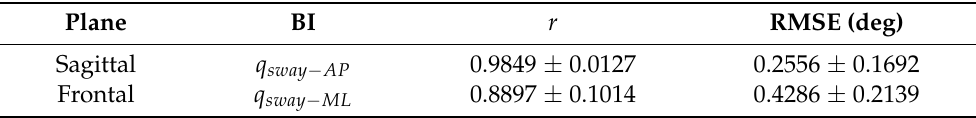
Table A2. Mean ± SD of the linear Pearson’s correlation coefficient ( r ) and RMSE for sagittal and frontal planes calculated between the sway angles ( q sway ) computed with the BenchBalance model and with Xsens MVN system. Values averaged across all the frontal and sagittal conditions of the